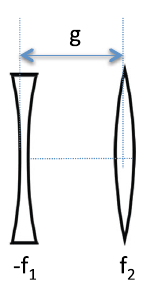
FIG. 3. A schematic layout of a half cell for a cell with a are focus lengths reflection symmetry. p , q , and f are the geometrical parameters ; 2 of the doublet. L 1 , L 2 are the distances to the entry and exit of the half